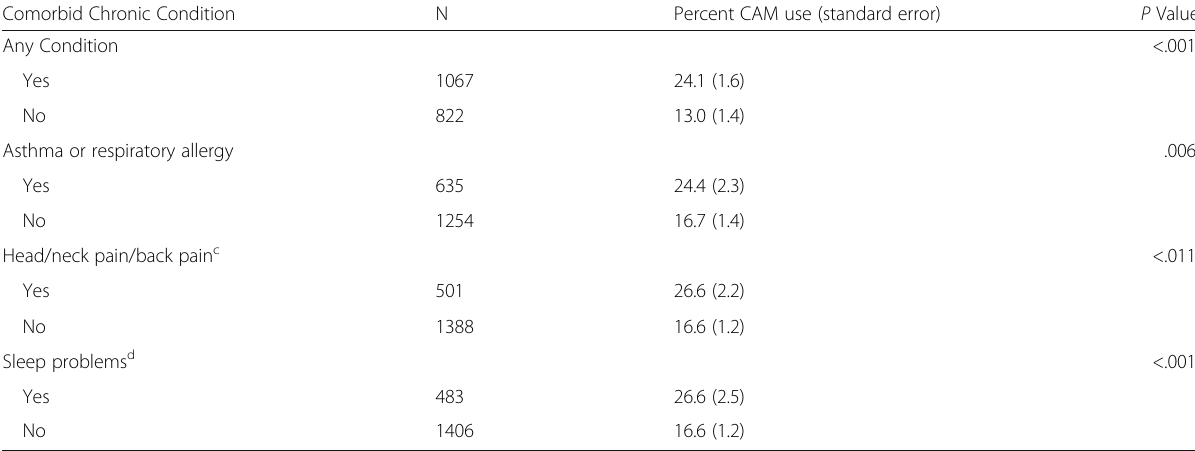
Table 4 Percent CAM use a in the last 12 months (standard error) by comorbid chronic condition among n = 1889 children reporting any mental health condition